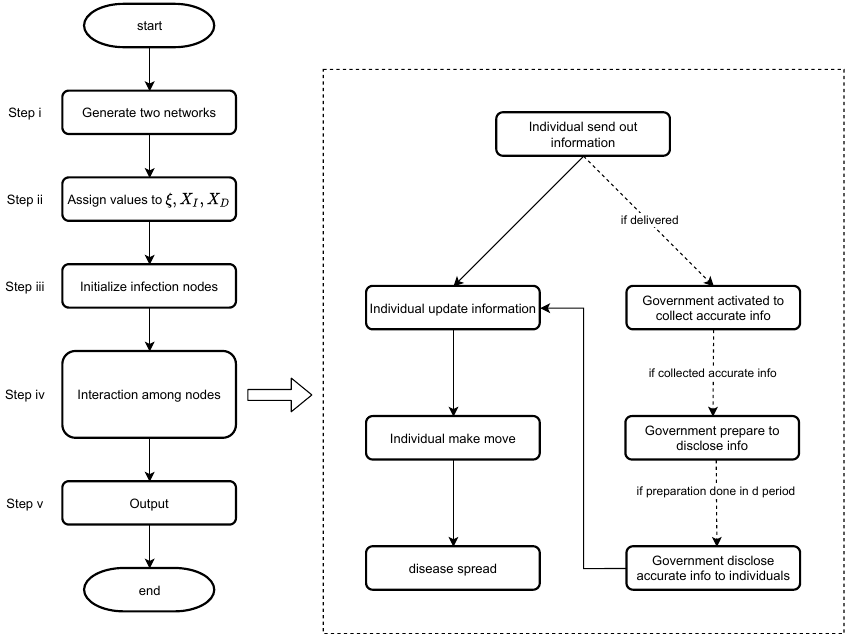
Figure 2. Flowchart of our simulation. In step ii, we assigned 4 × 11 × 11 = 484 different values. Then, we repeated steps iii and iv each for 50 times,